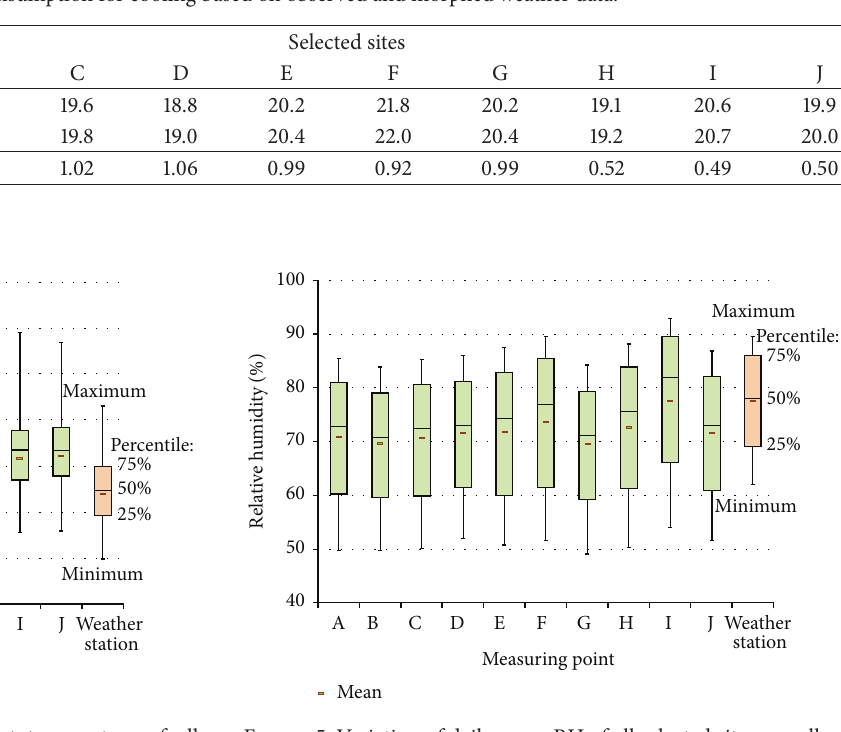
Figure 5: Variation of daily mean RH of all selected sites as well as the weather station during July to October